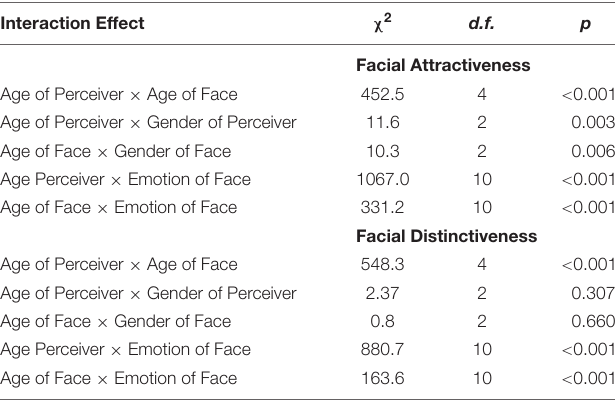
TABLE 3 | Wald tests for interaction